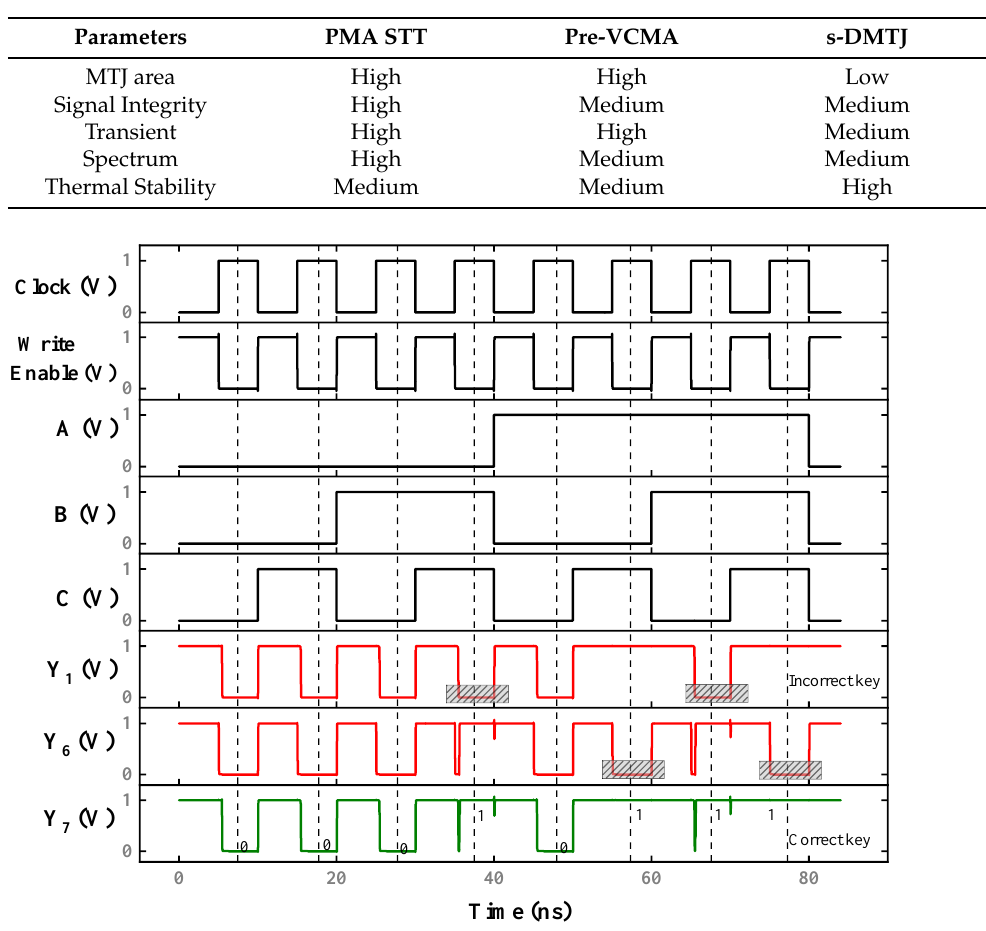
Figure 7. Output Y for the test circuit under different key combinations indicating LL